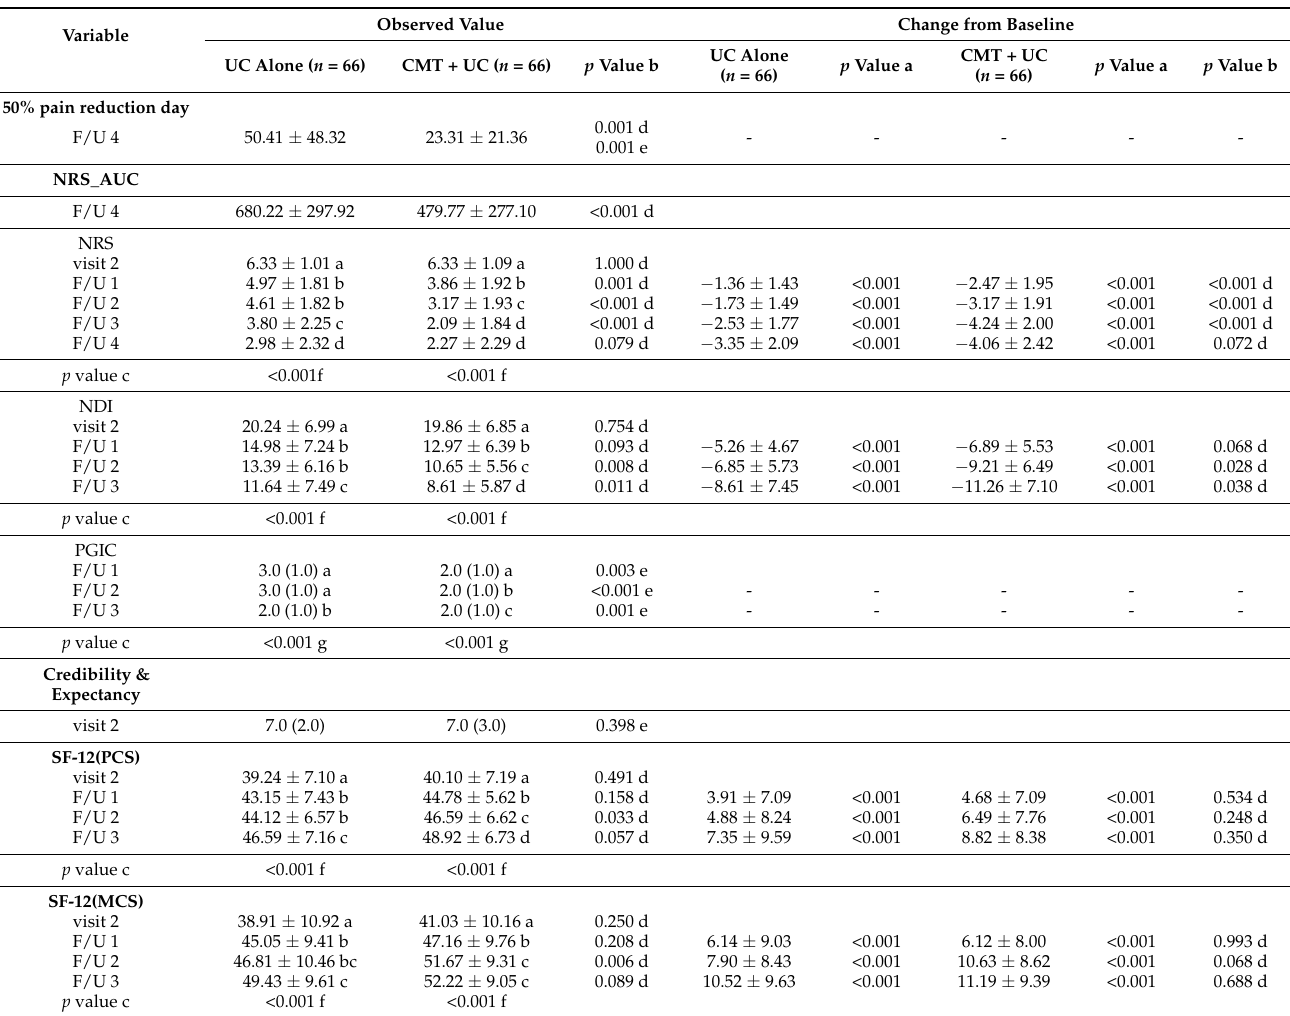
Table 2. Intention-to-treat analysis of primary and secondary outcomes of whiplash injury